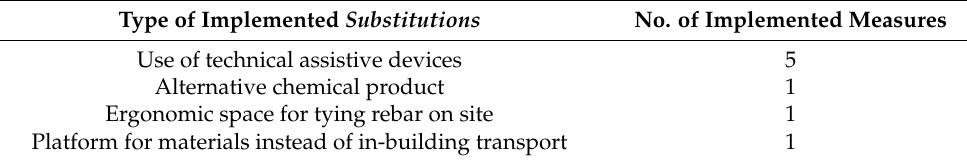
Table 1. Subcategories of successfully implemented substitution measures.